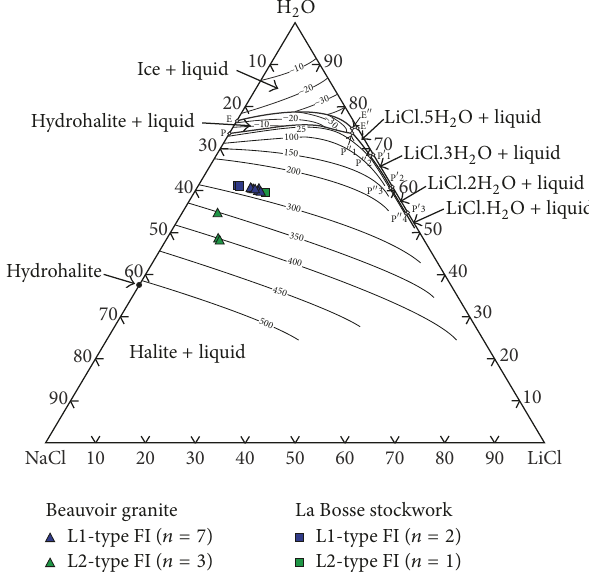
Figure 10: Phase diagram of the H 2 O-NaCl-LiCl system (after [44]) in which the microthermometric data of the L1- and L2-type fluid inclusions are reported. Concentrations are expressed in wt.%. E, E 󸀠 , and E 󸀠󸀠 refer to the eutectic points and P, P 󸀠 , and P 󸀠󸀠 refer to the peritecticpoints(valuesgivenin[44]).Isothermsaregivenin ∘ Cand were extrapolated for T > 100 ∘ C in the stability field of halite from the isotherms of the H 2 O-NaCl-CaCl 2 diagram from Bodnar [43] (see explanation in text). Estimations of the bulk salinity and Na/Li ratios for the different fluid inclusions are reported in Table